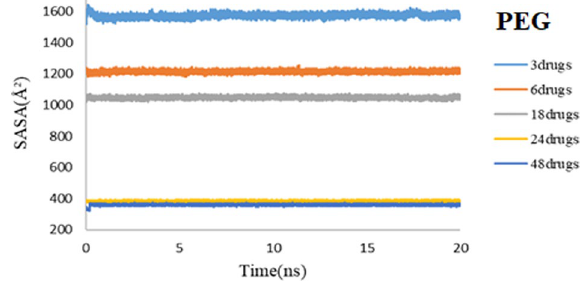
Figure 16. SASA values of 3TC-PEG complex for 3, 6, 18, 24, and 48 drug molecules during 20 ns simulation